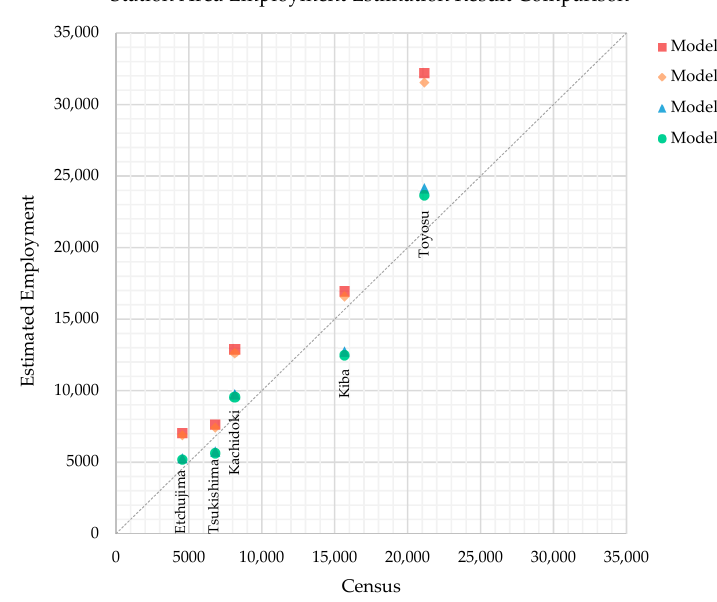
Figure 2. Scatter plots of the estimated counts versus census-based counts: population (top) and employment (bottom).